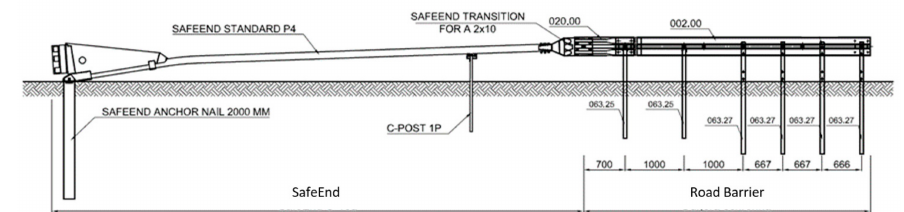
Figure 2. SE geometric diagram and dimensions [mm].